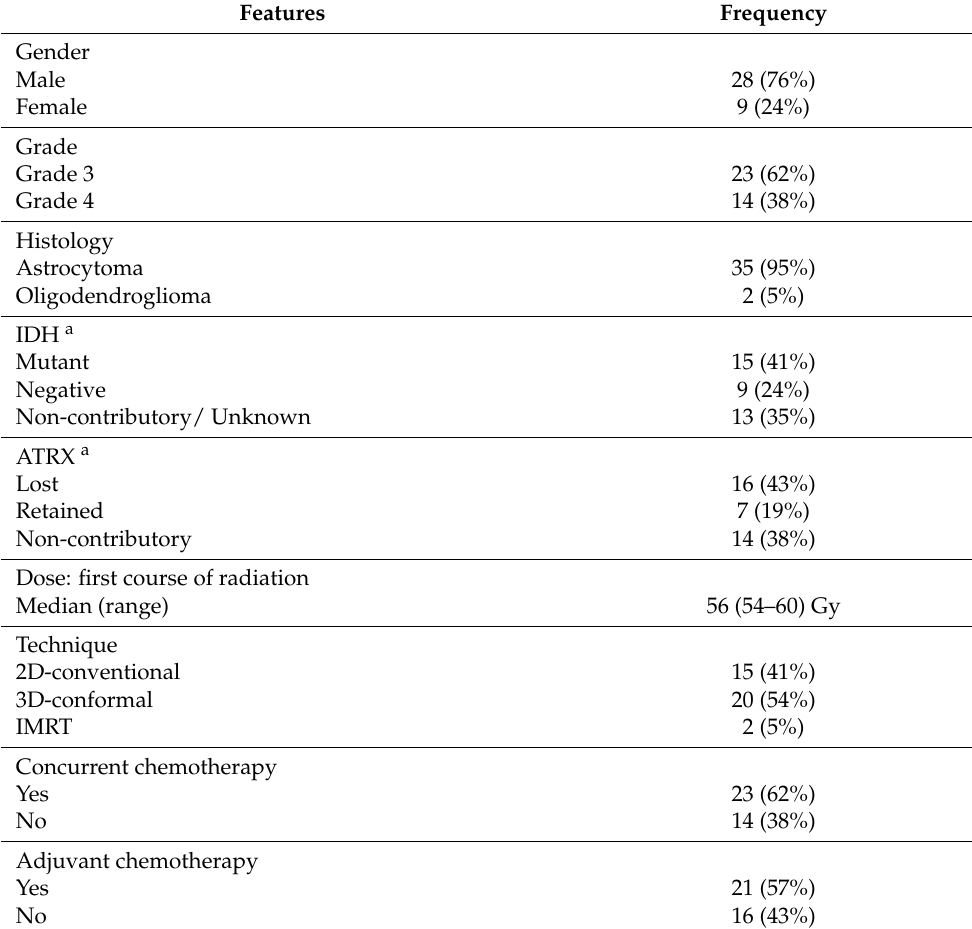
Table 1. Clinical characteristics and details of first course of treatment.